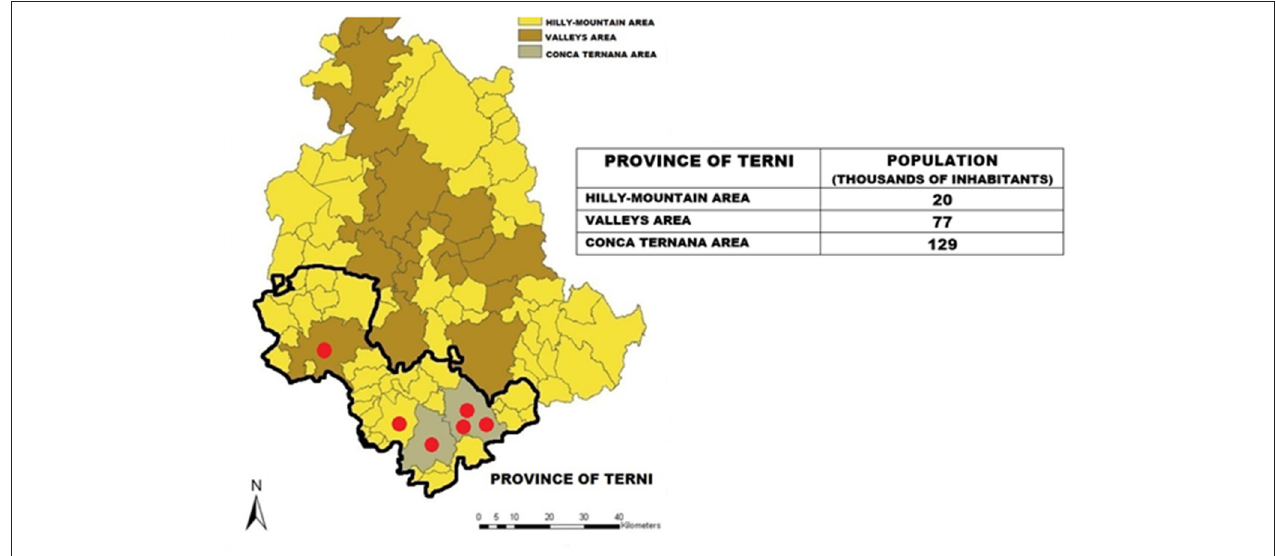
FIGURE 1 | Geographical map of the province of Terni showing the distribution of the network of fixed public monitoring stations, consisting of six units located within the main city centers of the Terni province with more than 10,000 inhabitants (Terni = 3, Narni = 1, Amelia = 1, Orvieto = 1, total population 161,771 people, representing the 72% of the province of